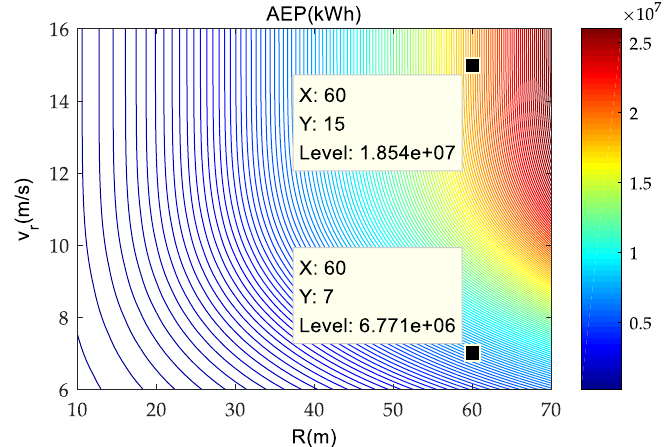
Figure 6. The two major component costs of offshore turbines versus the annual mean wind speeds and the shape factors: ( a ) the turbine system cost; ( b ) the station balance cost.